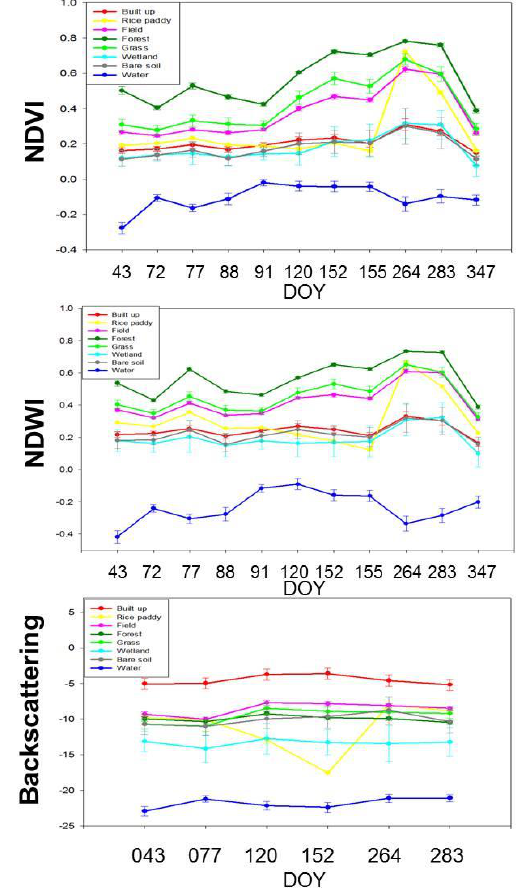
Figure 3 Time series of NDVI, NDWI and